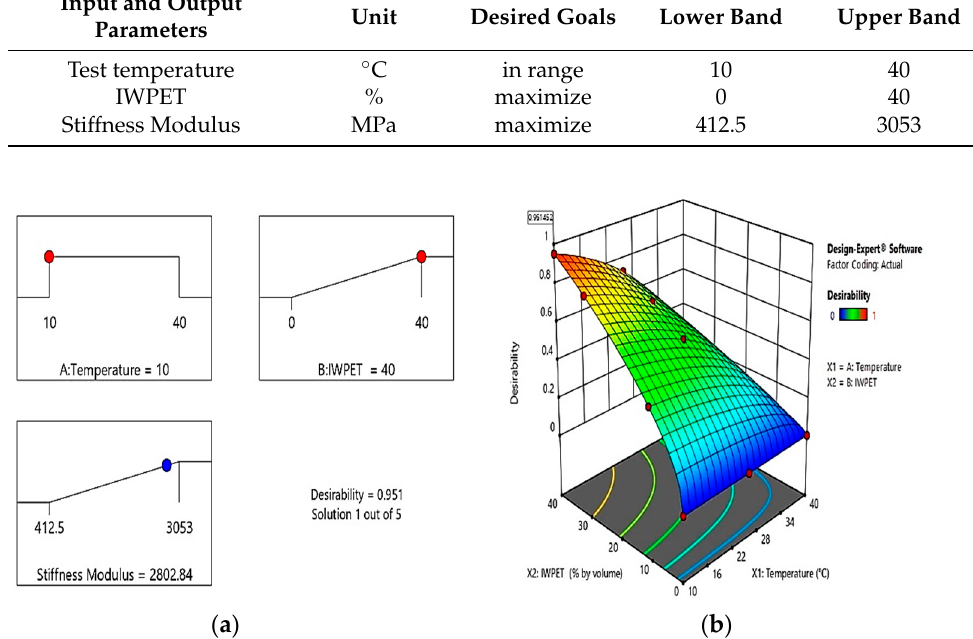
Figure 13. ( a ) Optimization ramps for the stiffness response; ( b ) desirability plot.